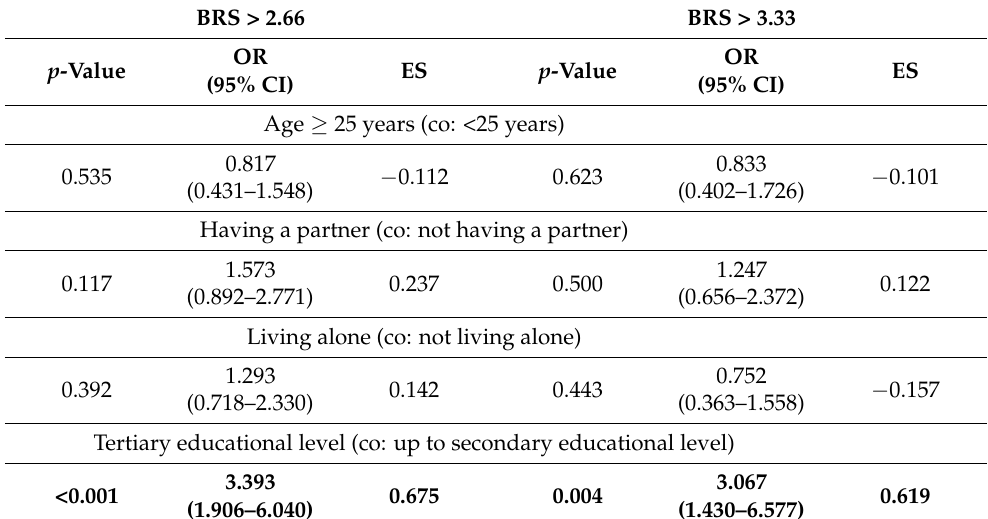
Table 2. Influence of demographic factors on resilience (univariate logistic regression analysis). BRS > 2.66 BRS > 3.33